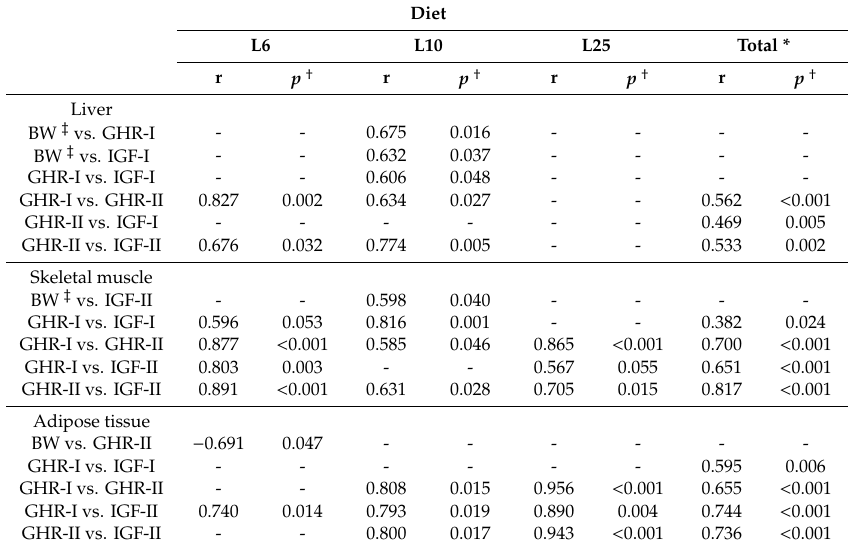
Table 3. Summary of correlation analysis of gene expression in liver, skeletal muscle and adipose tissue of fish fed the experimental